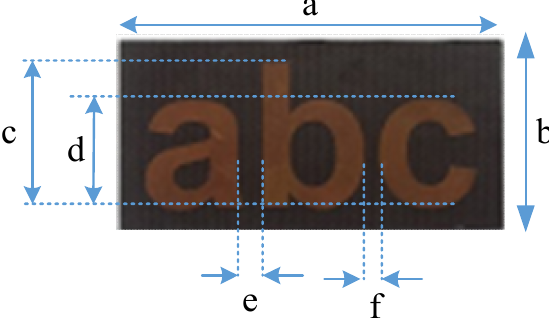
Figure 2. Top real view of the letter tag-abc. Values of the geometrical parameters are: Font = Arial, Font size = 15, a = 40 mm, b = 20 mm, c = 15 mm, d = 11.35 mm, e = 1.90 mm, and f = 1.5 mm.